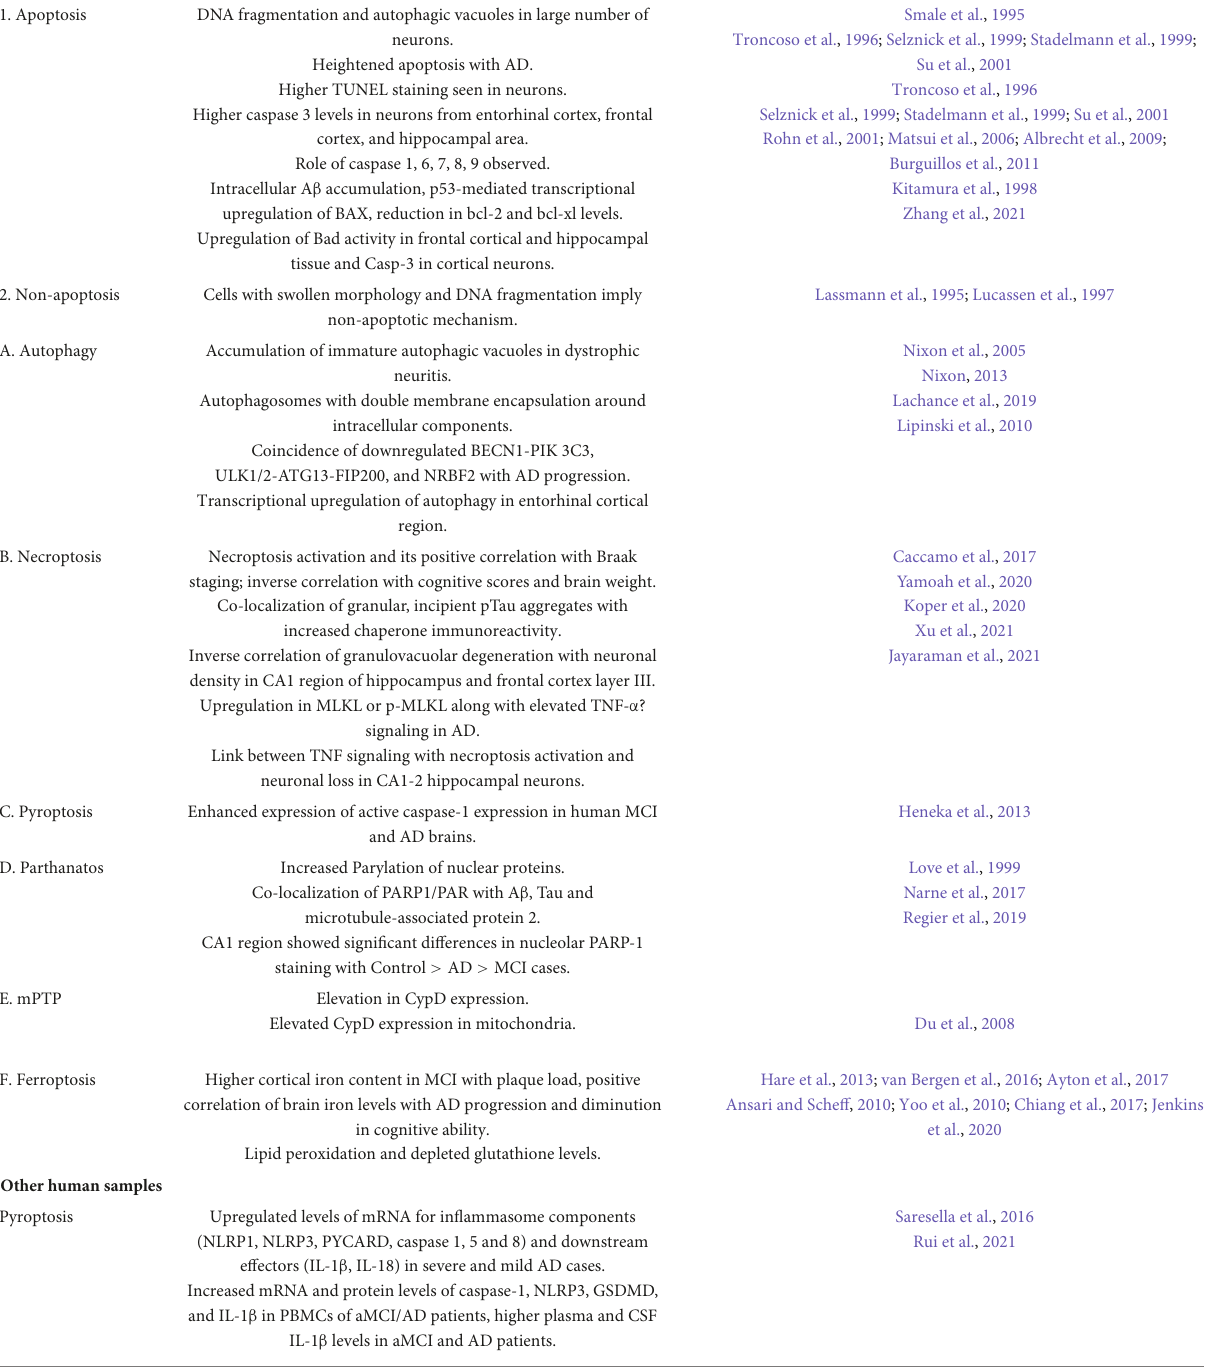
TABLE 1 Cell death pathways responsible for neuronal death in postmortem AD brains with evidence from various studies. Post-mortem studies in AD